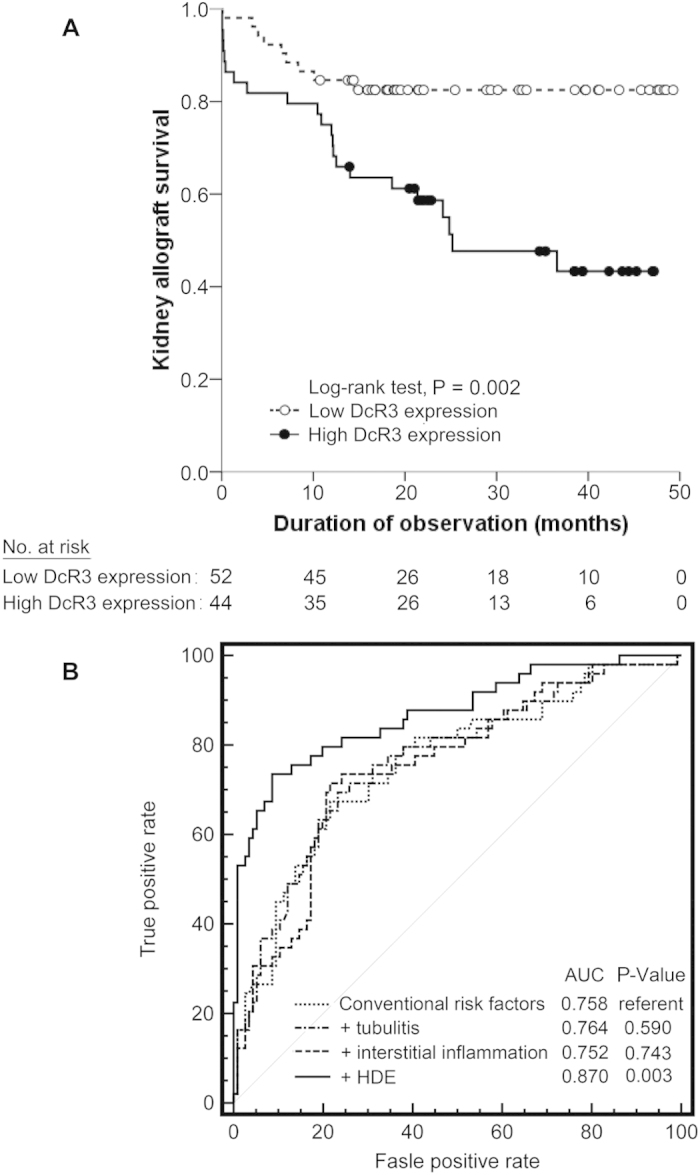
Survival curves and receiver operating characteristic (ROC) curve for predictability of outcome in renal transplant recipients with high and low DcR3 expression.(A) Kaplan-Meier cumulative curves for end points of the composite: doubling of serum creatinine or graft failure. (B) Risk prediction was assessed by the ROC curve. Each biomarker was added stepwise to the model of conventional risk factors to assess the AUC change for predicting progression of kidney disease in allografts. Conventional risk factors included age, sex, hypoalbuminemia, eGFR, proteinuria and chronic allograft damage index (CADI).